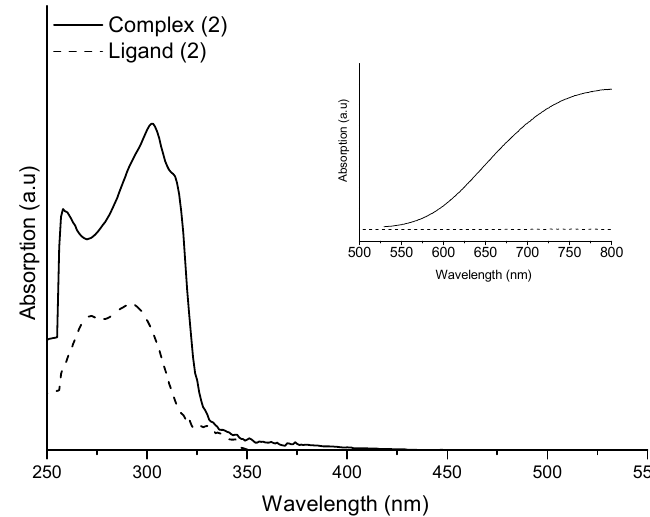
Figure 3. Absorption spectra of the complex 2 and free ligand measured at 298 K using the same concentration (1 × 10 − 5 M H 2 O/DMSO (95/05%).